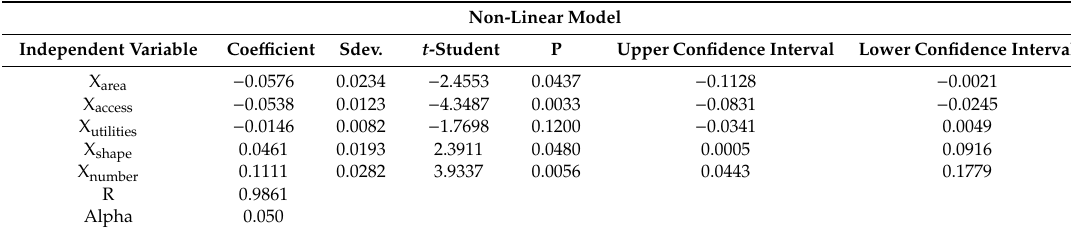
Table 5. Modeling results for the non ‐ linear model.